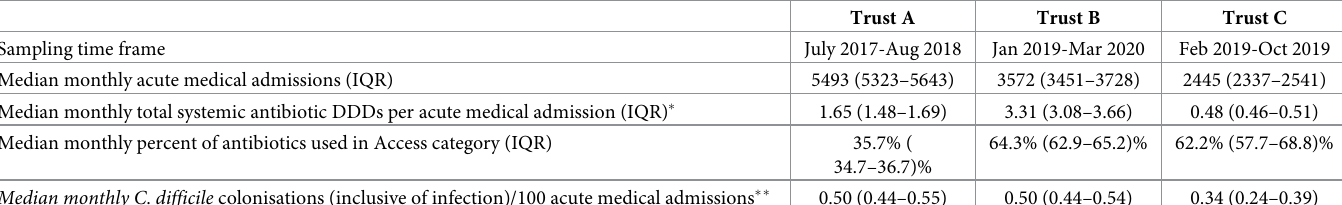
Table 1. Characteristics of participating